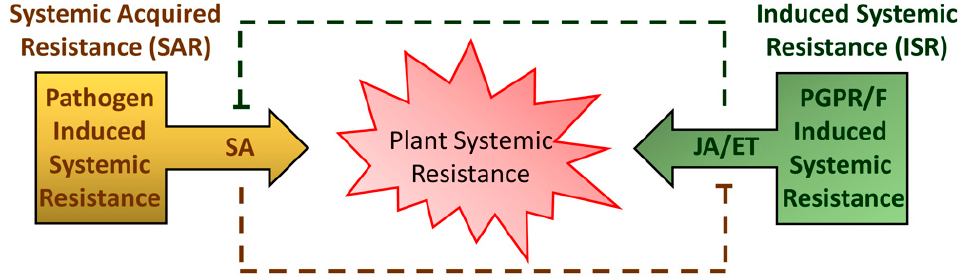
Figure 1. Scheme of different types of plant systemic resistance. The systemic acquired resistance (SAR) is triggered upon pathogen attack. Local defenses are followed by the production of mobile signals—mainly salicylic acid (SA)—that prime distal plant parts for defense compounds accumulation. Induced systemic resistance (ISR) can be triggered by colonization with plant-growth-promoting rhizobacteria or fungi (PGPR/F). ISR is regulated mainly by jasmonic acid (JA) and ethylene (ET).